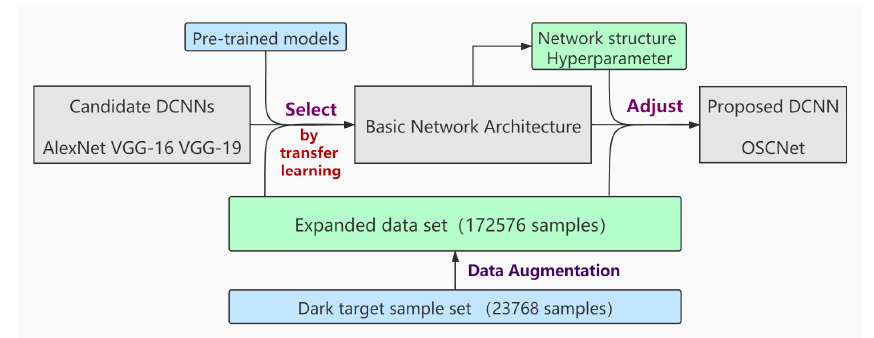
Figure 1. The design flowchart of the Oil Spill Convolutional Network (OSCNet) based on candidate deep convolutional neural networks (DCNNs).